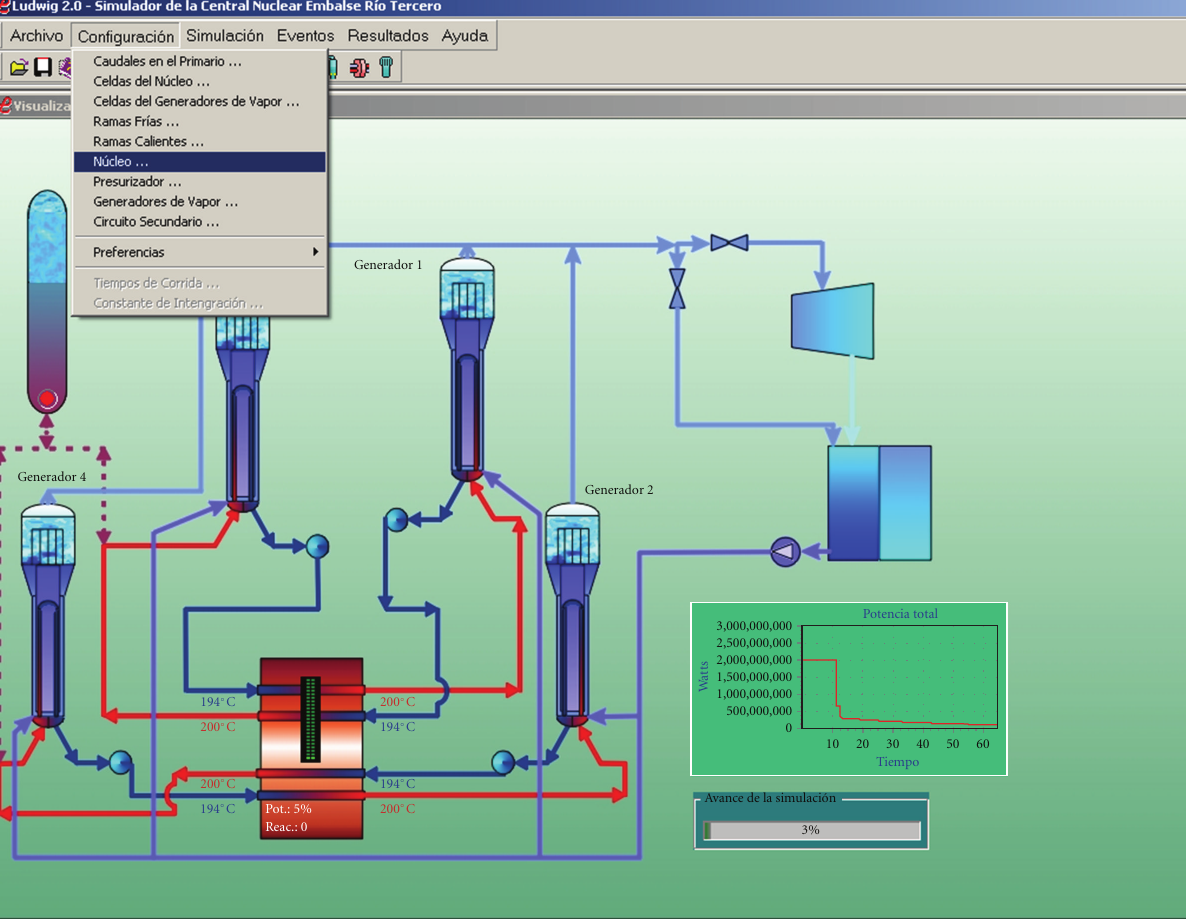
Figure 1: Ludwig mimic interface of the